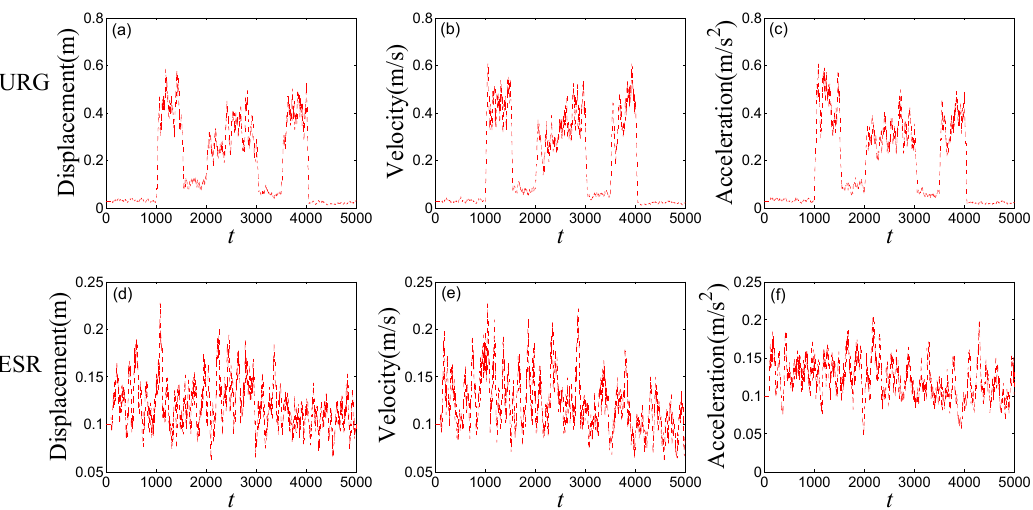
Figure 9. The measurement noise V-C matrix R of the local-filter output of URG and ESR in the first experiment (The R of displacement of ( a ) URG and ( d ) ESR, the R of velocity of ( b ) URG and ( e ) ESR and the R of acceleration of ( c ) URG and ( f ) ESR).